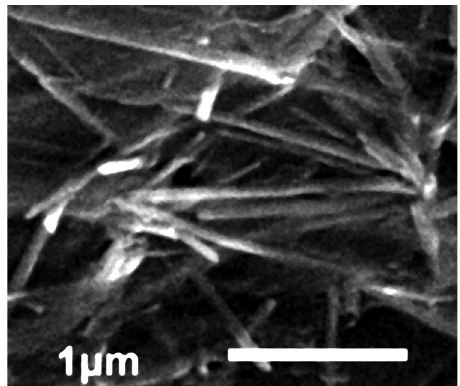
Figure 3: SEM imaging for the structural features of Se - NRs synthesized with pomegranate